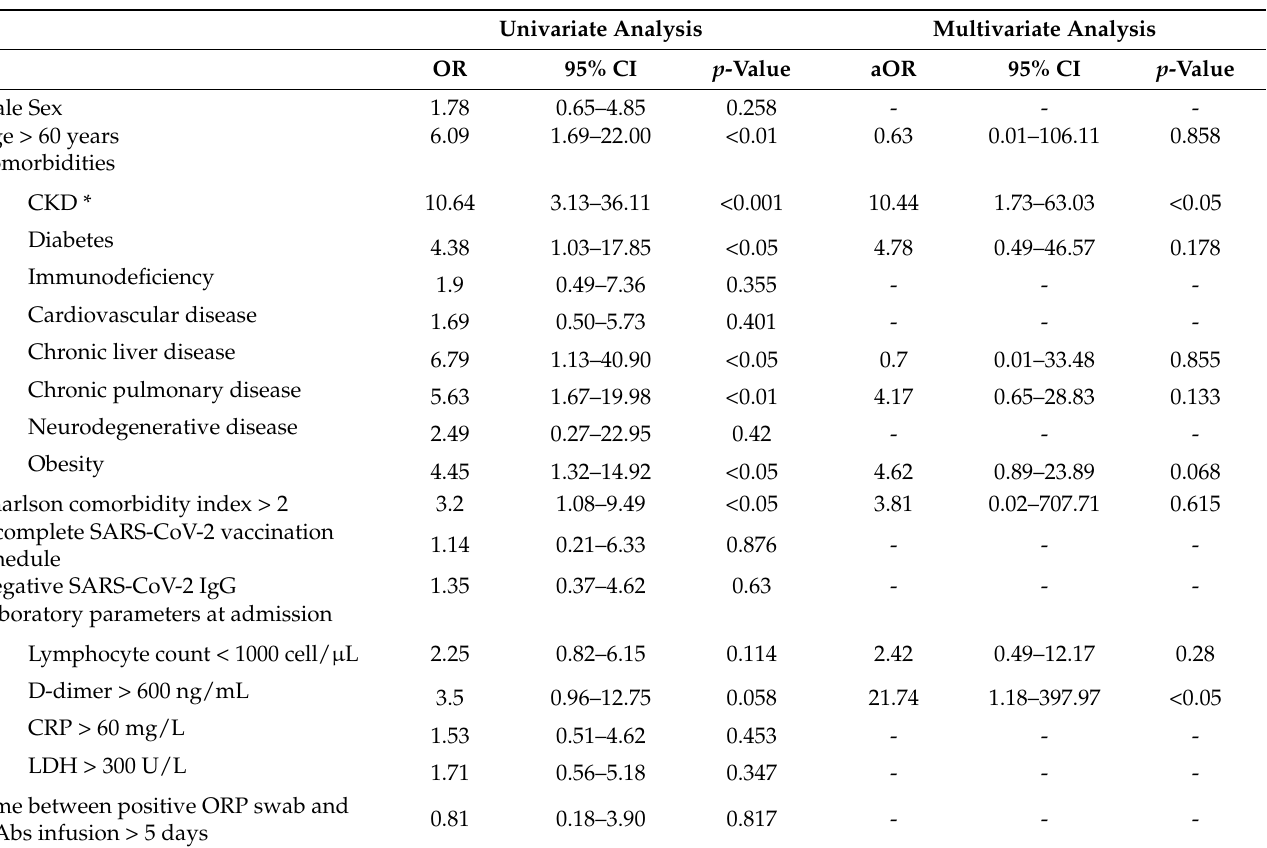
Table 2. Univariate and multivariate logistic regression analysis for SARS-CoV-2 infection unfavorable outcome. Univariate Analysis Multivariate